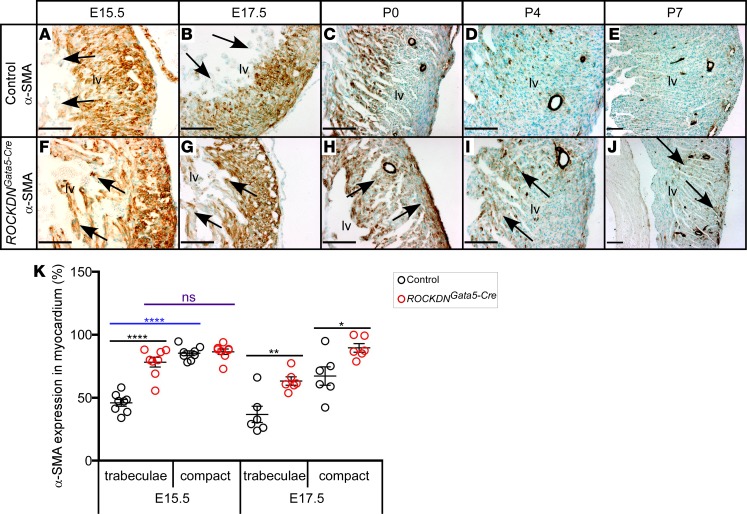
Delayed maturation of cardiomyocytes in ROCKDNGata5-Cre mutants.(A–E) The pattern of α-SMA expression was investigated by immunohistochemistry and visualized by DAB staining, and a representative image of the left ventricular wall, from each age, is shown. In control hearts at E15.5 and E17.5, α-SMA became restricted to the compact myocardium and was no longer expressed in trabeculae (arrows in A and B). Postnatally, expression was further restricted to the smooth muscle of coronary arteries, with no cardiomyocyte staining by P7 (C–E). In contrast, in ROCKDNGata5-Cre mutants, α-SMA staining persisted in trabeculae at E15.5 and E17.5 (arrows in F and G), and there were patches of cardiomyocyte expression postnatally (arrows in H–J). (K) The level of α-SMA expression was measured by ImageJ in trabeculae and in the compact myocardium. The total area of trabeculae or the compact myocardium was measured throughout the heart, and the percentage of this area in which α-SMA was expressed was calculated. This confirmed that α-SMA expression was retained longer in trabeculae in ROCKDNGata5-Cre mutants, as there were significantly higher levels of α-SMA expression at E15.5 and E17.5 in trabeculae of mutants compared with trabeculae of littermate controls. Furthermore, in control hearts at E15.5, there was a significant difference in α-SMA expression levels between trabeculae and the compact myocardium (blue line), confirming, as expected, that the expression was becoming restricted to the compact myocardium. In contrast, in ROCKDNGata5-Cre mutants, there was no significant difference between expression levels in trabeculae and compact myocardium (purple line; NS). By E17.5, there was a significant difference in expression levels in the compact myocardium between controls and mutants, showing that, as expected, expression in control hearts was beginning to decrease in the compact myocardium as the cardiomyocytes matured and that this process was delayed in ROCKDNGata5-Cre mutants. n = 8 for E15.5 and n = 6 for E17.5 for each genotype. Data are presented as mean ± SEM. *P < 0.05, **P < 0.01, ****P < 0.0001 by 1-way ANOVA with Bonferroni’s correction for multiple comparisons. lv, left ventricle. Scale bars: 100 μm.